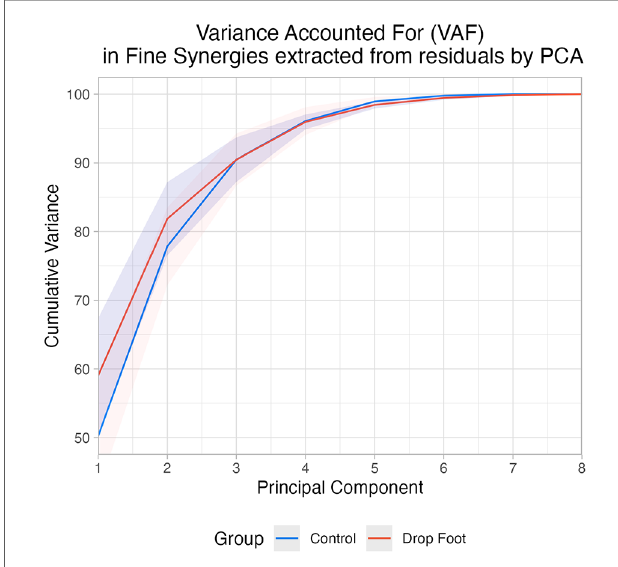
FIGURE 3 Cumulative variance accounted for each PC extracted from residuals by PCA in drop foot (DF) and control (C).